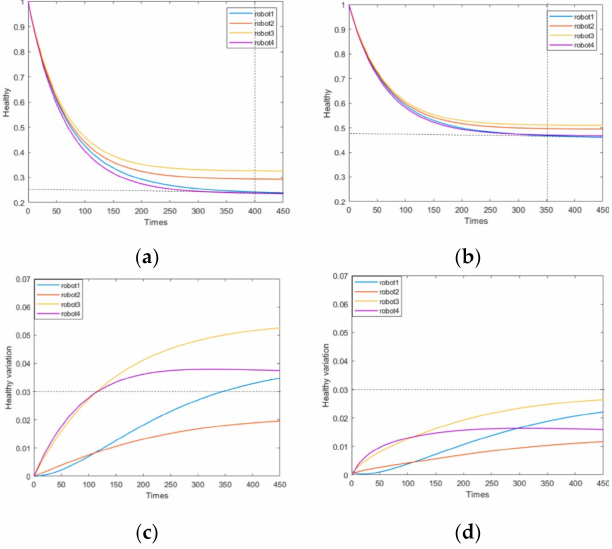
Figure 11. Comparison before and after adding HOM in the first scenario: ( a ) h i ( t ) of the robot under normal conditions; ( b ) h i ( t ) of the robot under HOM; ( c ) e i ( t ) under normal conditions; ( d ) e i ( t ) under